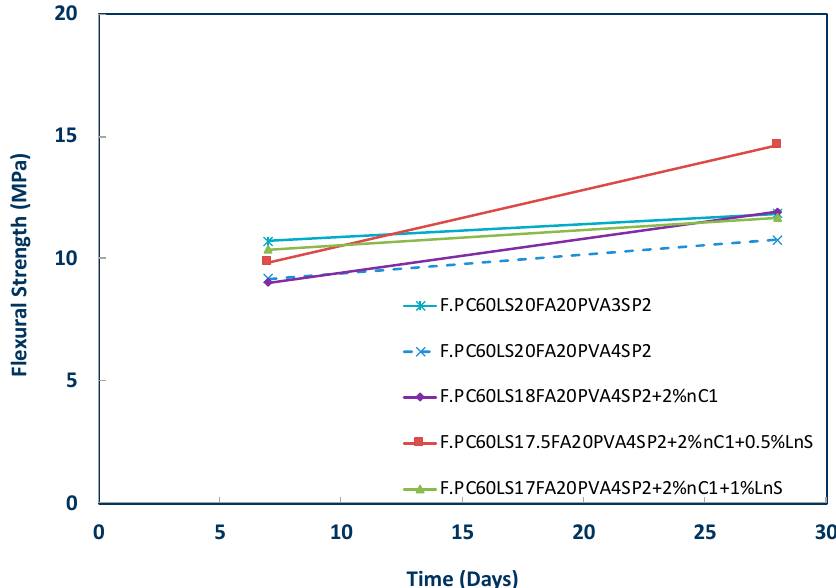
Figure7. FlexuralstrengthofnC1andnanosilica(LnS)andfibrereinforcedcementitiousnanocomposites Figure 7. Flexural strength of nC1 and nanosilica (LnS) and fibre reinforced cementitious based on nanocomposites based on F.PC60LS20FA20PVA4SP2.